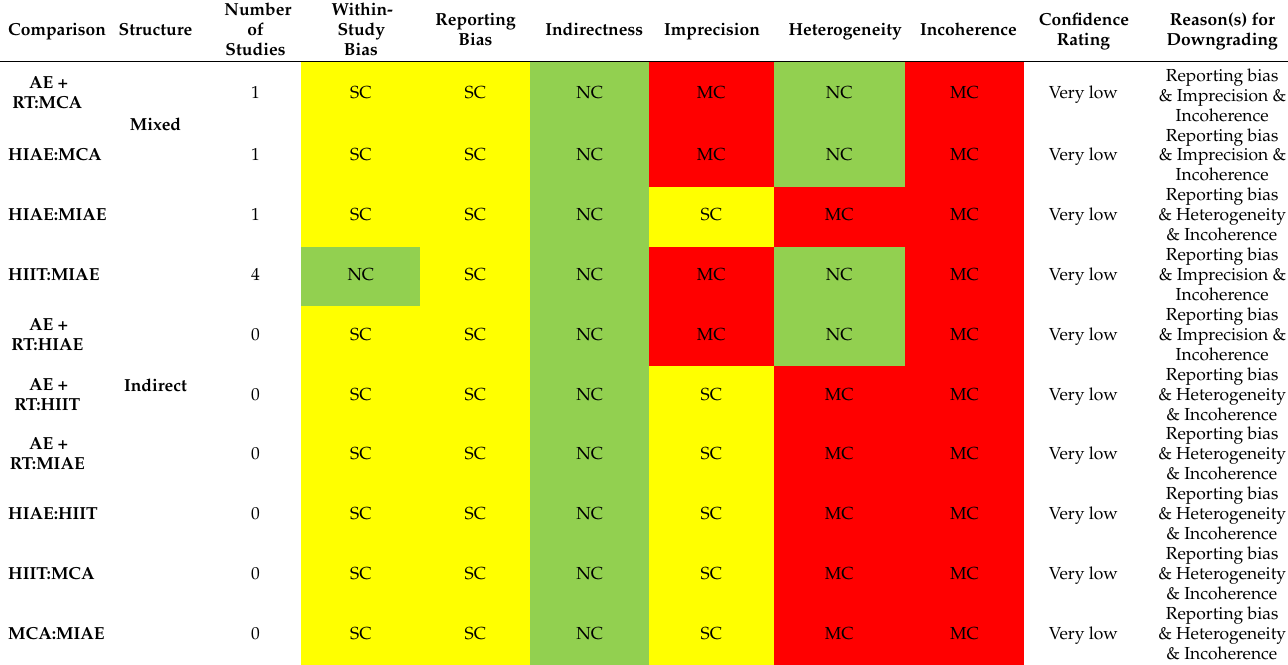
Figure 7. Contribution to the average risk of bias of each pair intervention comparison. Table 4. Results of the confidence assessment.